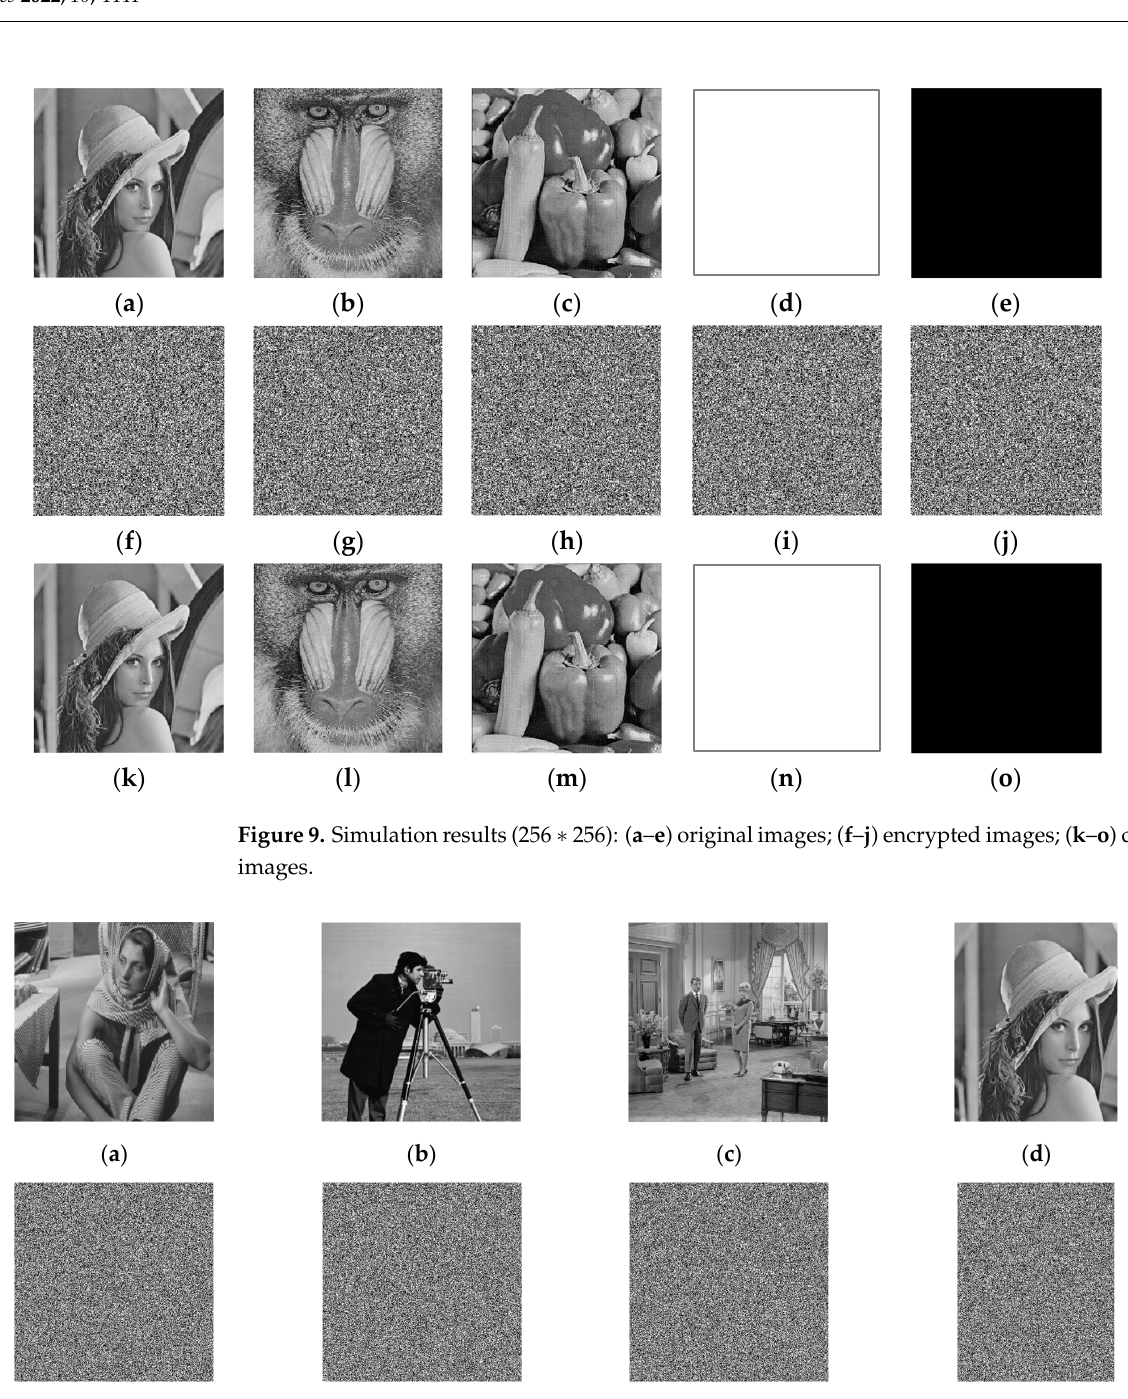
( f ) Figure 11. Histogram Analysis (256 ∗ 256): ( a – c ) original images; ( d – f ) encrypted image.